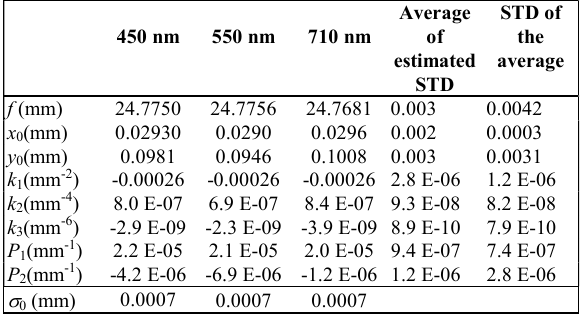
Table 6. Results obtained with the images cropped with a fixed value for the crops origins: estimated values for the IOPs of images of the visible bands, average values of estimated standard deviations and standard deviations of the average values. 850 nm Estimated Differences (Average visible – IR) STD 